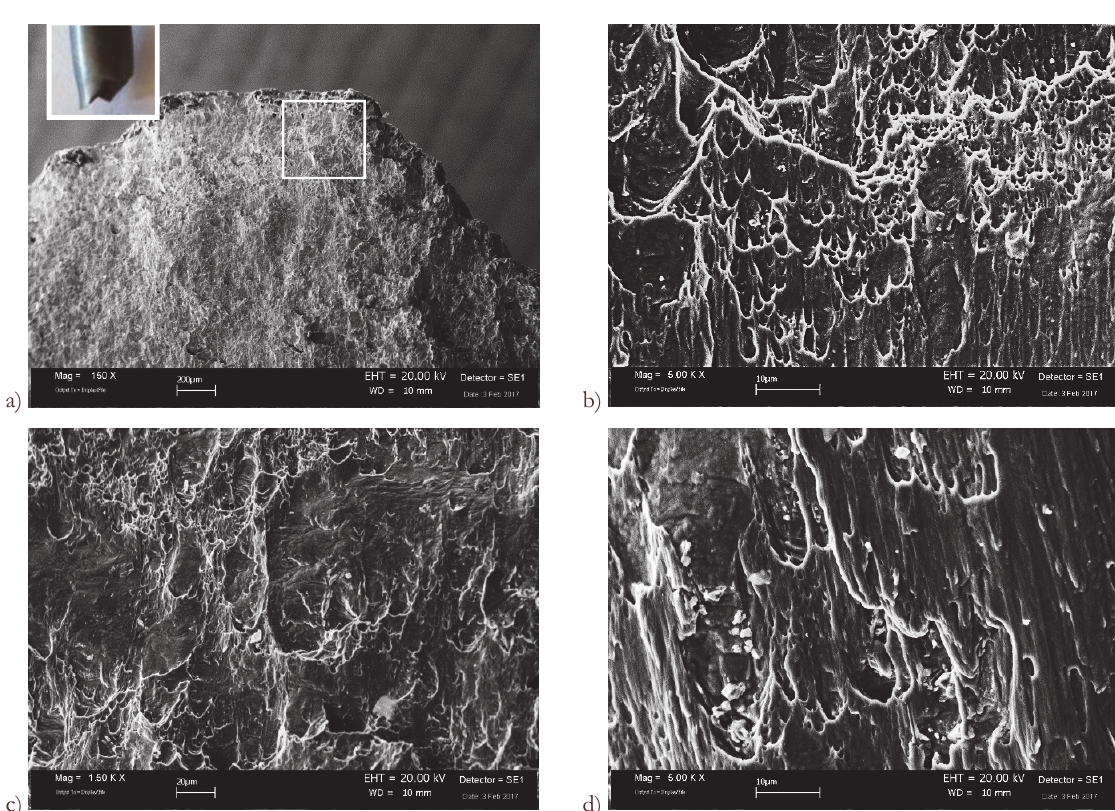
Figure 14: SEM micrographs: a) fracture surface at low magnification; b) portion of surface showing a dominant ductile fracture mode; c) portion of surface showing both transgranular and ductile fraction; d) deformation bands: elongated dimples on fracture surface.